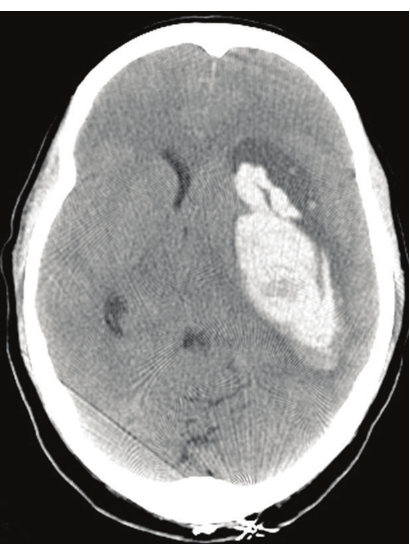
Figure 1: Cranial CT without contrast demonstrating a 9 × 4 × 6.6 cm left deep intraparenchymal hemorrhage without any associated SAH, with 1cm midline shift.